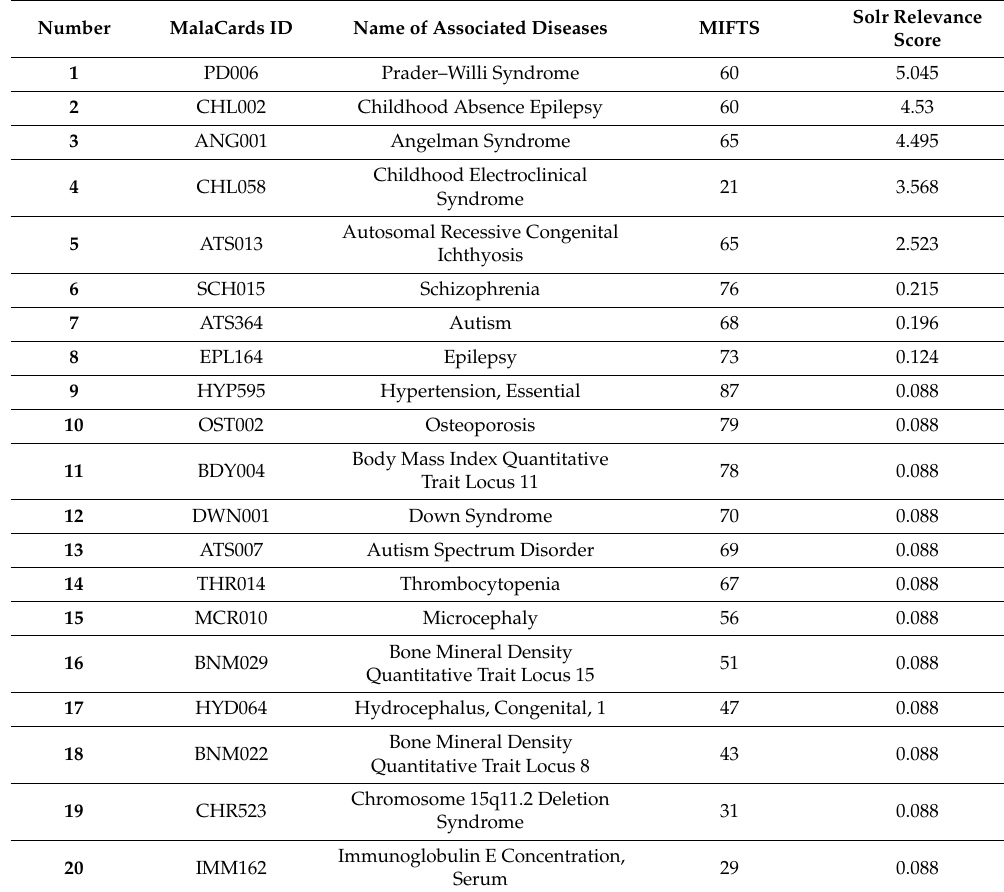
Table 7. Putative Associated Diseases for the NIPA2